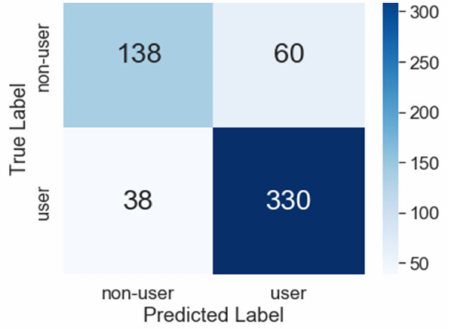
Figure 7. LR model confusion matrix heatmap for the test/holdout